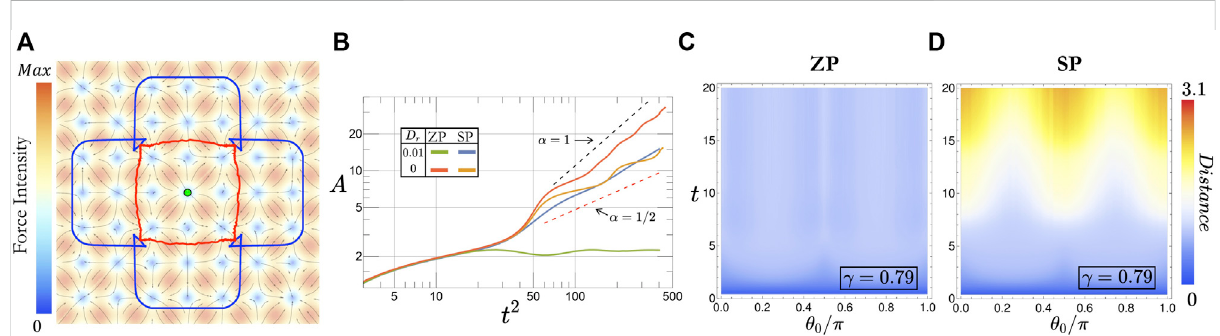
FIGURE 4 (A) Comparison between the noiseless (blue curve) and noise-averaged (red curve) isochrones at time t = 9. Color gradient indicates the intensity of theexternal force fi eld, and the gray arrows inits direction. (B) Areaenclosed by the isochrones as afunction ofsquaredtime for both ZP and SP with and without rotational noise. (C) Color maps of the average distance from the starting point as a function of the initial orientation θ 0 and time t forbothZP(leftcolumn)andSP(rightcolumn)inpresenceofrotationalnoise.Alldatashownin (A – C) areaveragedover10 2